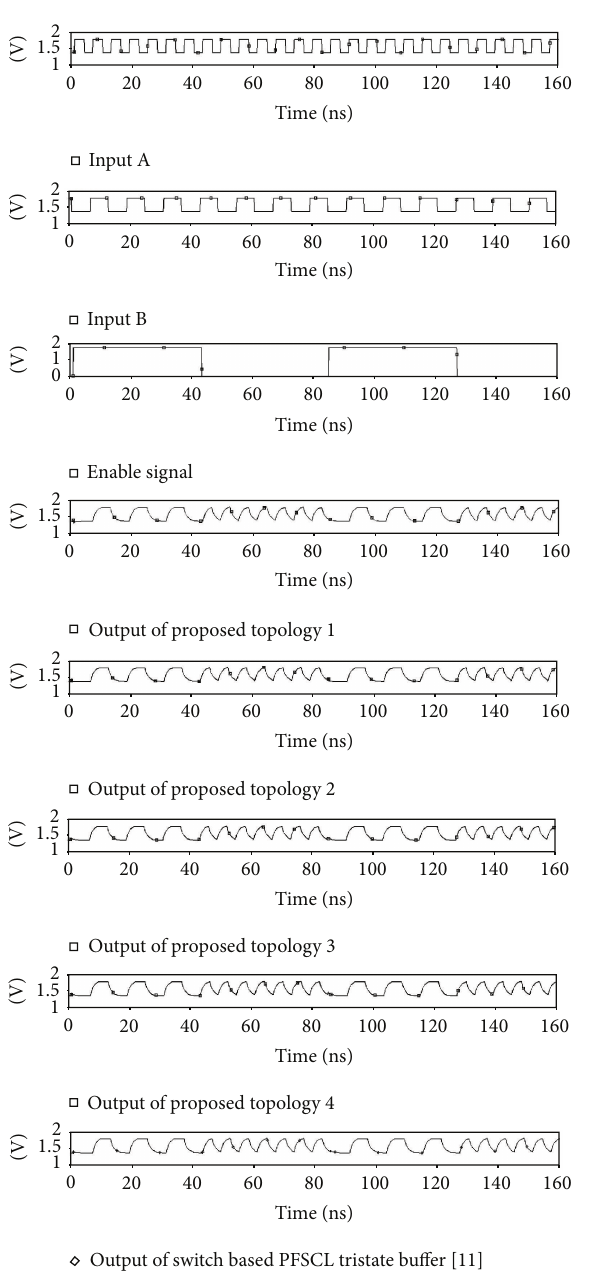
Figure 7: Simulation waveforms of the proposed and available switch based [11] PFSCL tristate buffer